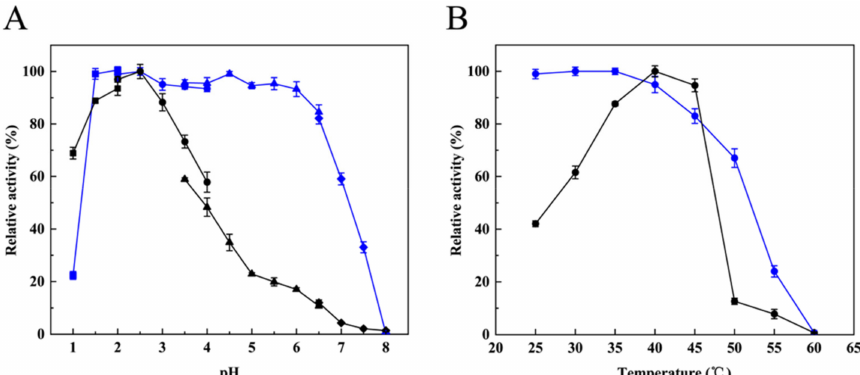
Figure 3. Optimal pH ( A , black polyline) and pH stability ( A , blue polyline) of RmproB, optimal temperature ( B , black polyline) and thermostability ( B , blue polyline) of RmproB. The optimal pH of RmproB was determined in 50 mM various buffers at 40 ◦ C. The buffers used are KCl-HCl ( (cid:4) ,